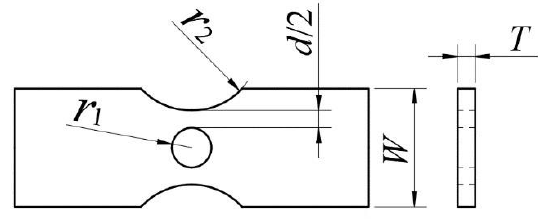
Figure 14. Diagram of dangerous section of the simulative specimen.